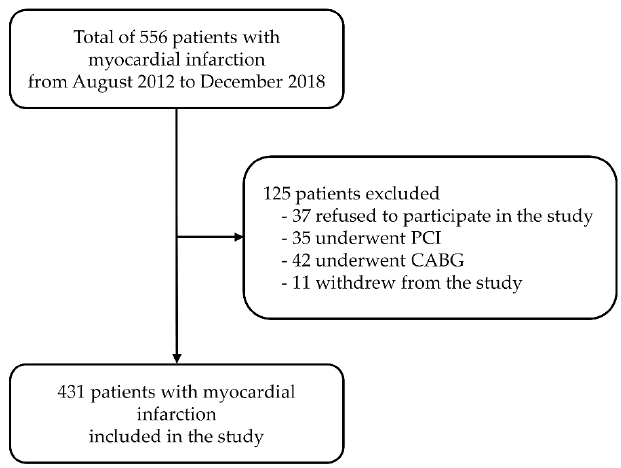
Figure 1. Patient selection flow chart. CABG—coronary artery bypass grafting, PCI—percutaneous coronary intervention.